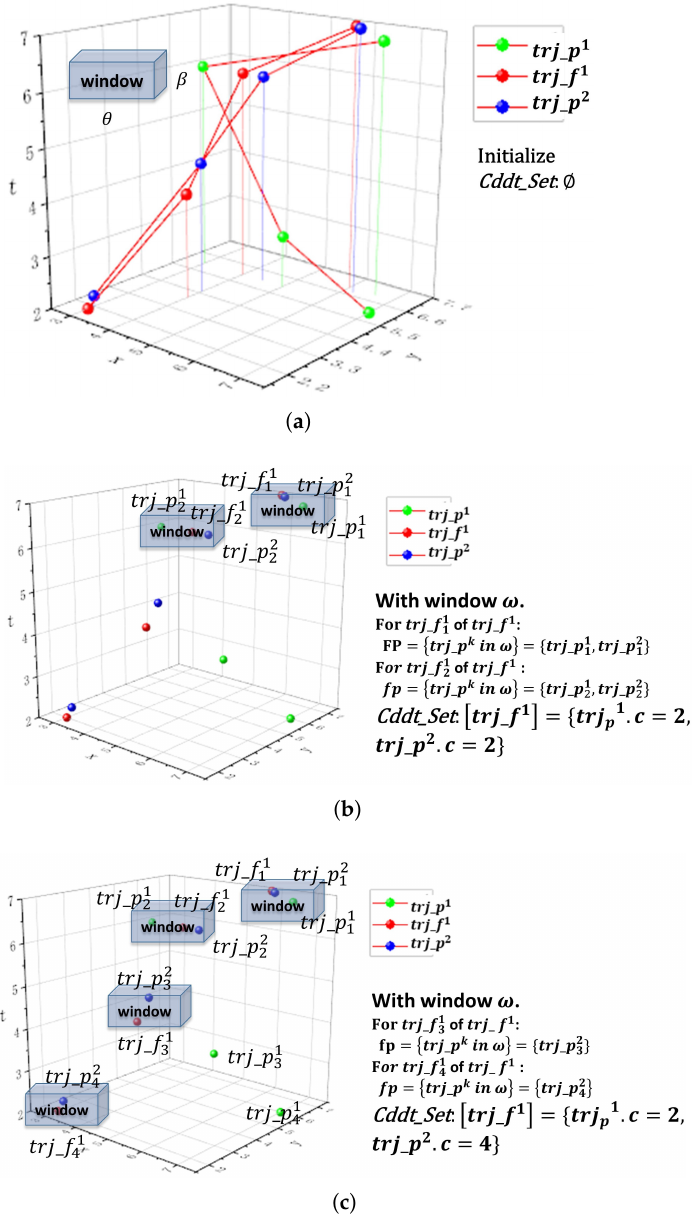
Figure 4. Example of how MGSTWS algorithm works (change of Cddt _ Set at 3 time points ( a – c